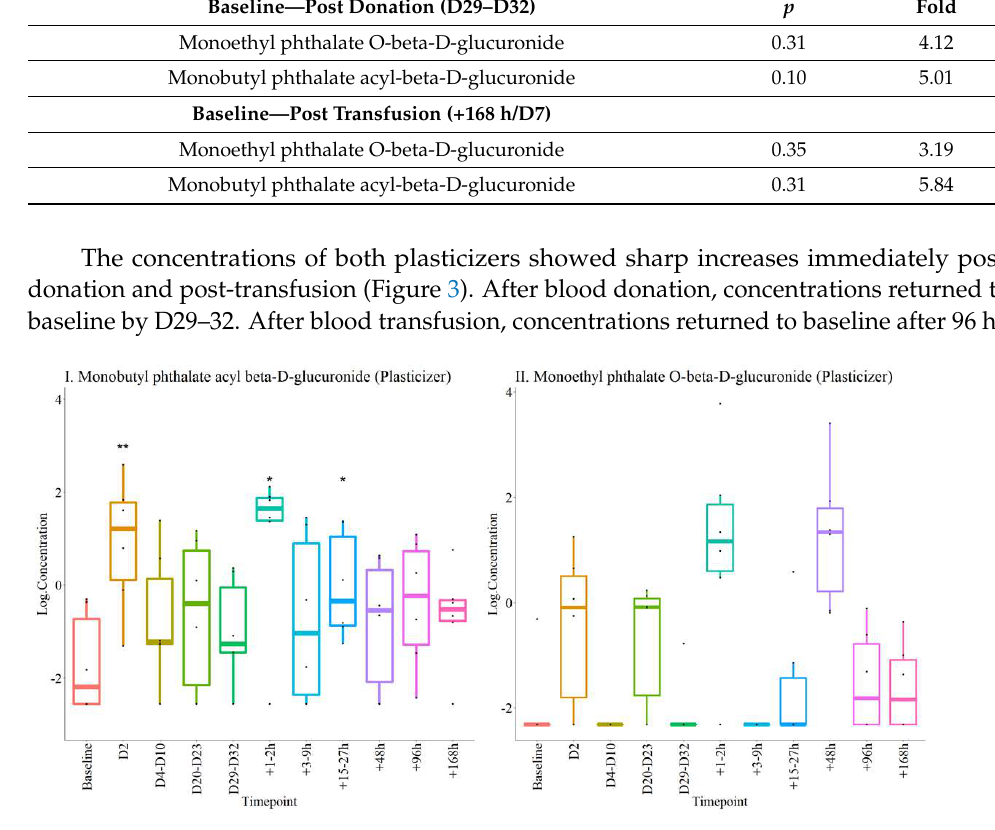
Figure 3. Box-plots detailing concentrations of plasticizers at all timepoints. I. Monobutyl phthalate acyl beta-D-glucuronide and II. Monoethyl phthalate O-beta-D-glucuronide. * p < 0.05, ** p < 0.01 compared with